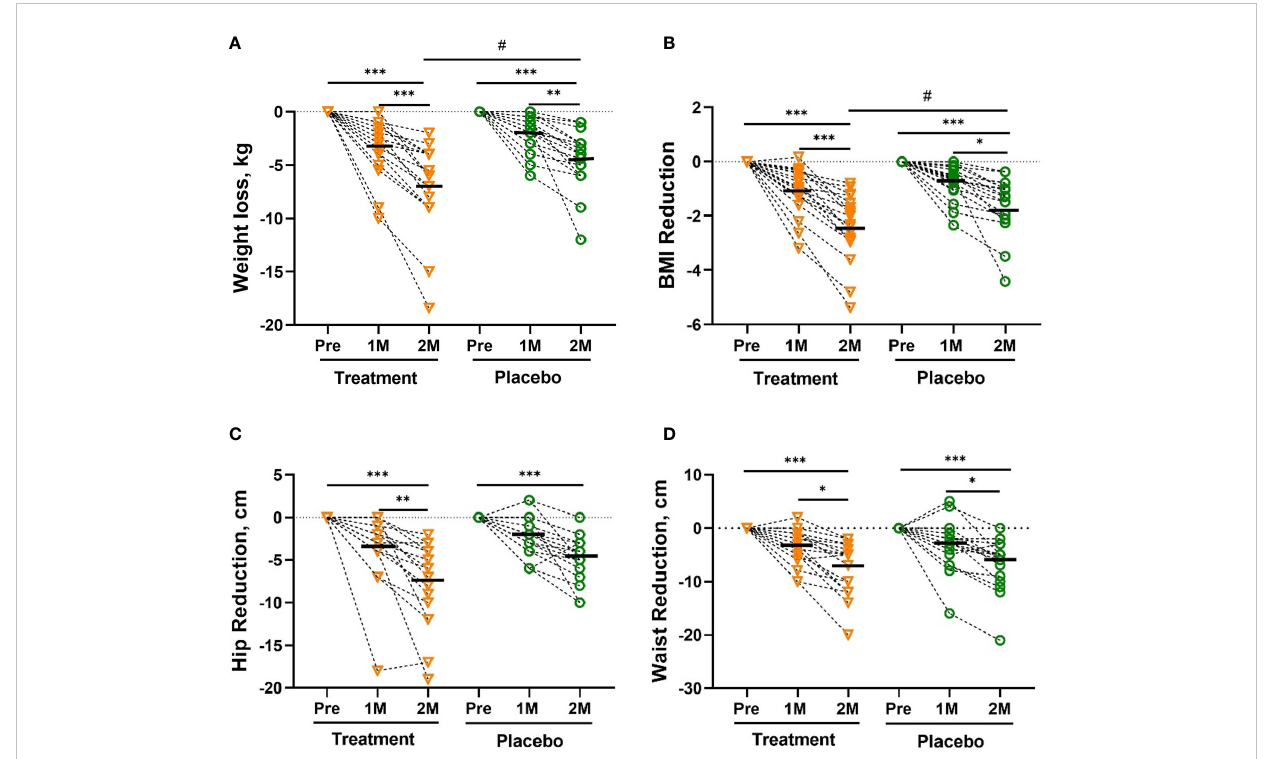
FIGURE 1 The Reduction in body weight (A) , BMI (B) , hip circumference (C) , waist circumference (D) . The reduction in body weight was signi fi cantly greater in the treatment group than in the placebo group after 2 months (2M). Bars were shown as mean of each group. All intra-group analysis were performed by using one-way ANOVA followed by bonferroni post hoc , and all inter-group analysis for baseline and treatment effects were performed by using t test followed by Mann-Whitney (# represents p < 0.05) by Prism 9 software (*, ** and *** represent p < 0.05, p < 0.01 and p < 0.001). Body mass index,